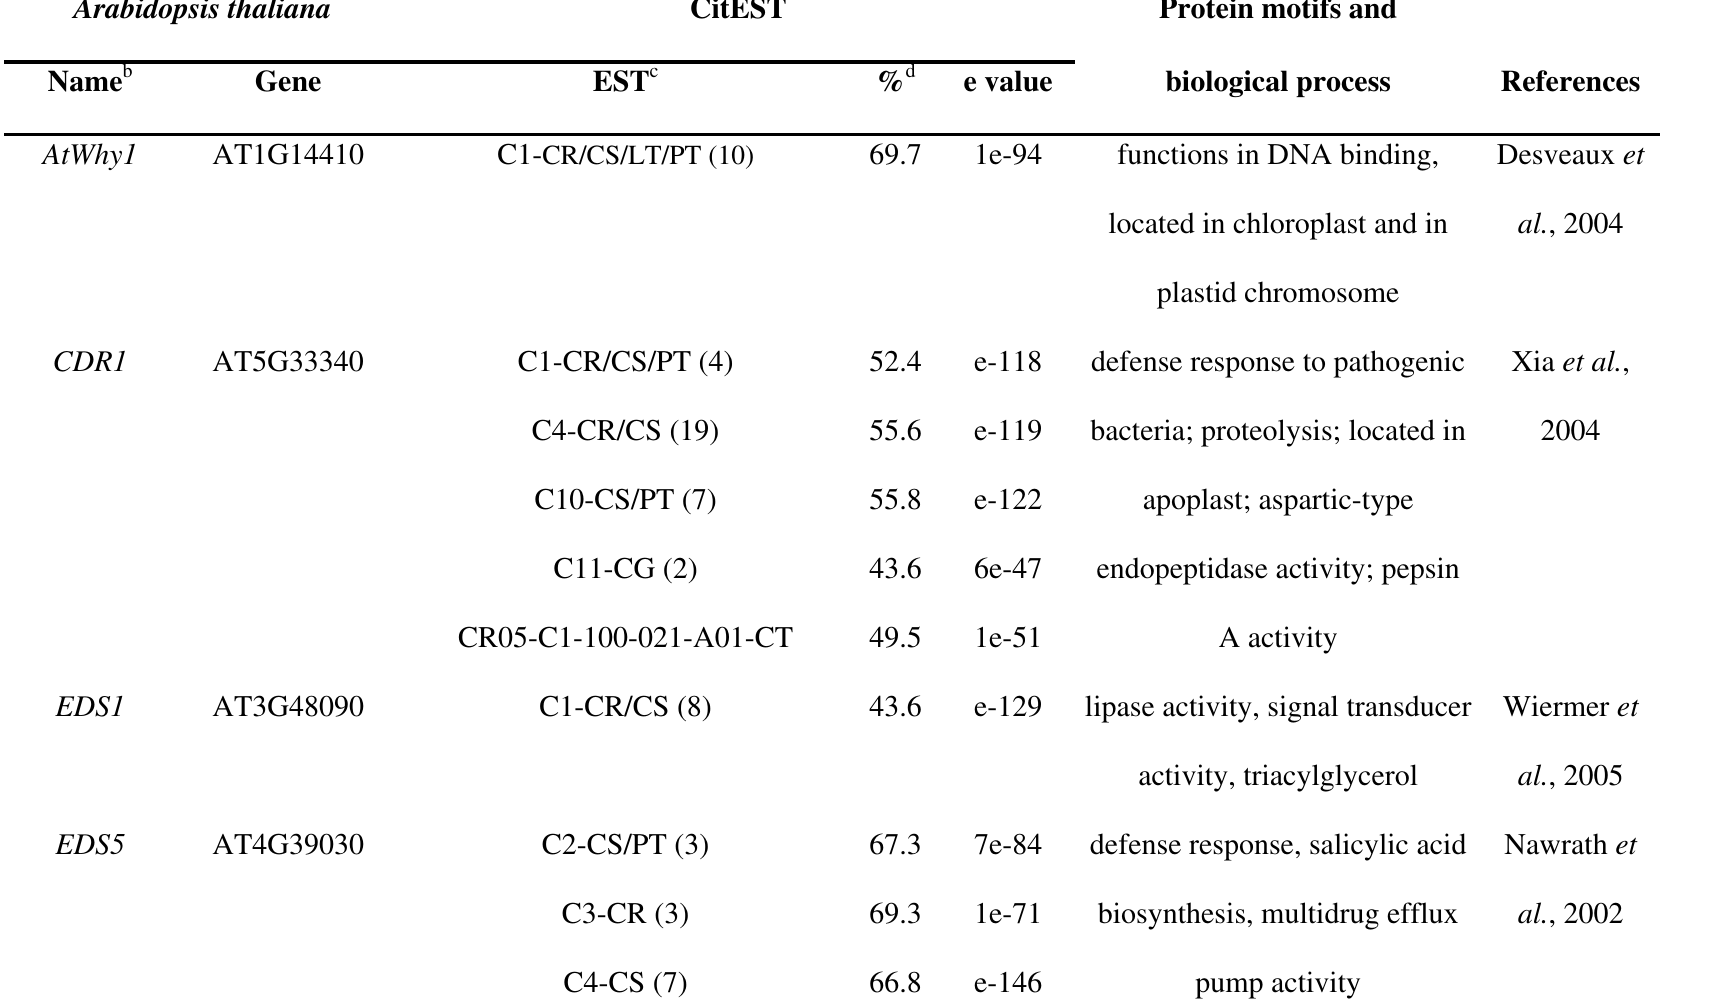
Table S15 – Citrus ESTs with homology to genes involved in salicylic acid signal transduction in plants a